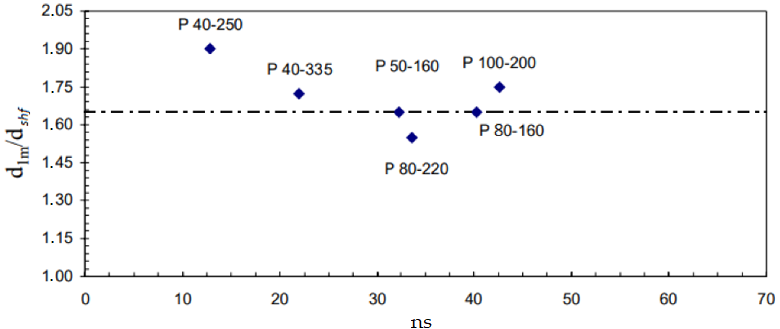
Figure 5. Statistical distribution of the ratio d 1m /d shf .